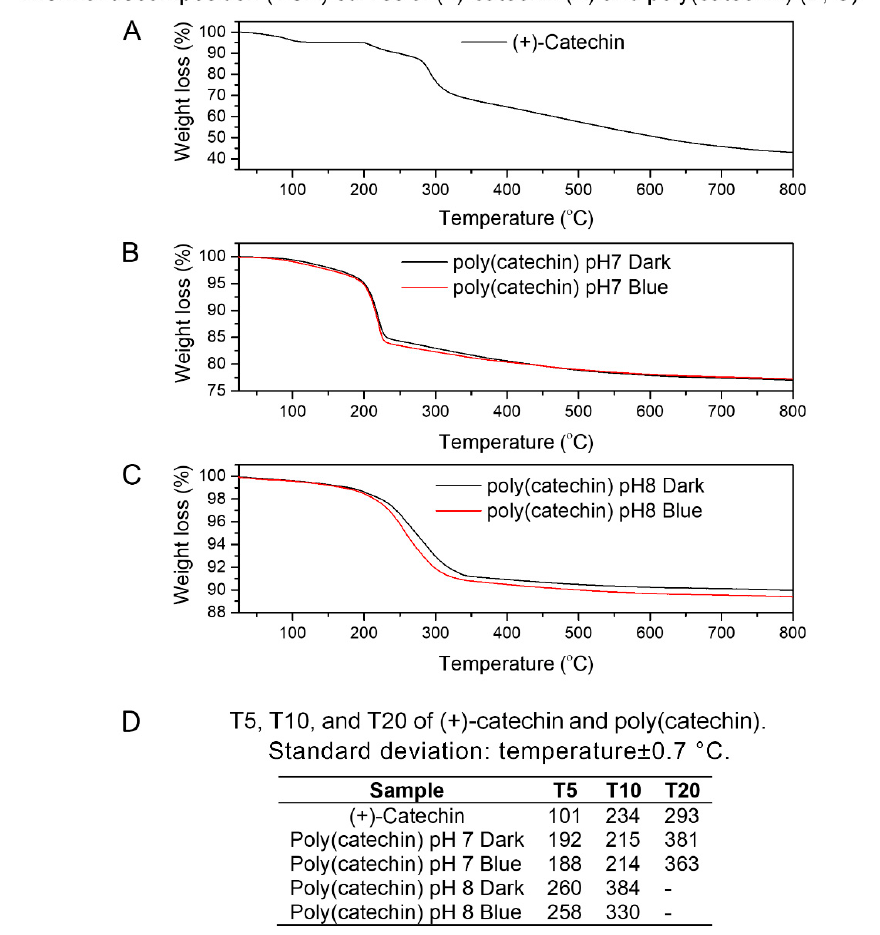
Figure 4. Thermal decomposition (TGA) curves of ( + )-catechin ( A ) and poly(catechin) ( B , C ). T5, T10, and T20 of ( + )-catechin and poly(catechin) ( D ).